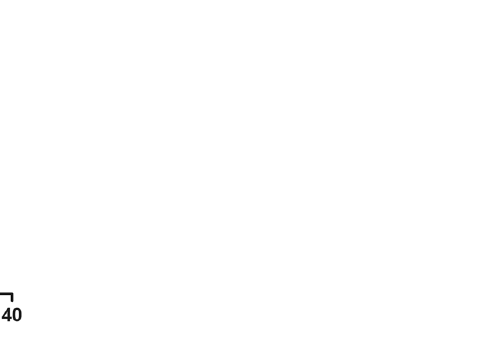
Figure 2. Relationship between Ct value (x axis) and the number of NoV reads per million reads (y axis, Log 10 ). A robust regression analysis was performed in Prism (Robust Sum of Squares: 36.72).